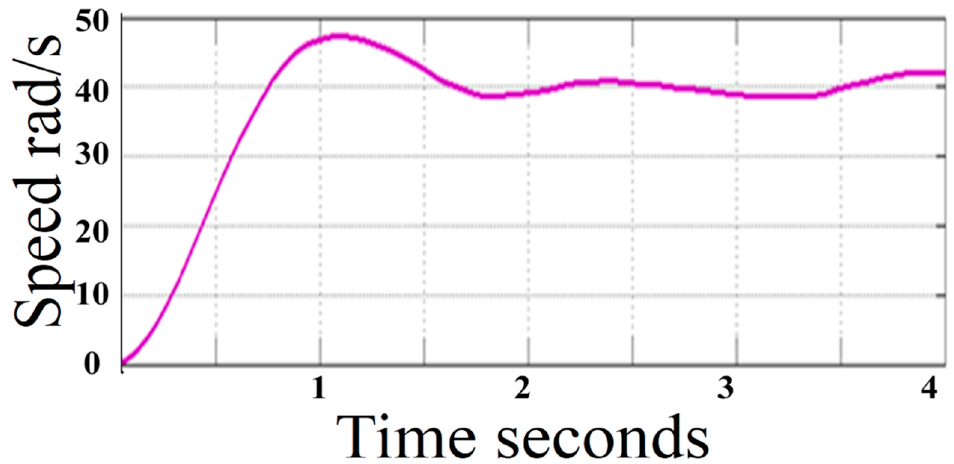
Figure 17. Simulation of the best result obtained in the experimentation with GT2FDE without noise in the FLC.